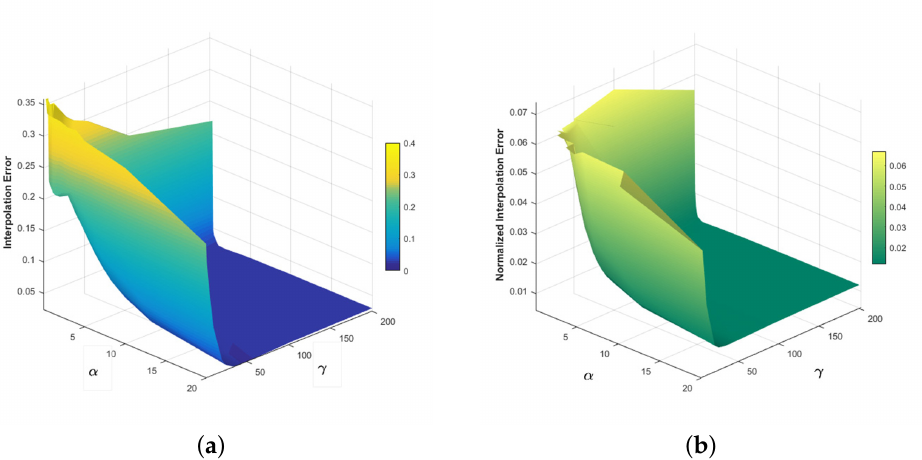
Figure 8. Interpolation Error ( a ) and Normalized Interpolation Error ( b ), for parameter sensitivity